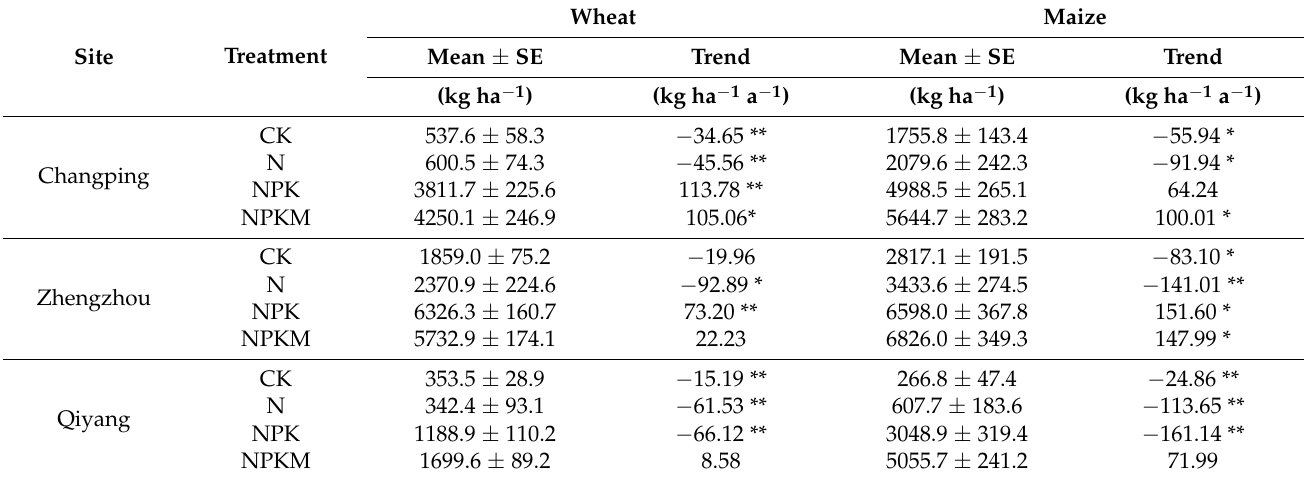
Table 2. Mean yields of wheat and maize and their changing trends affected by long-term fertilization during 1991–2010. Site Treatment